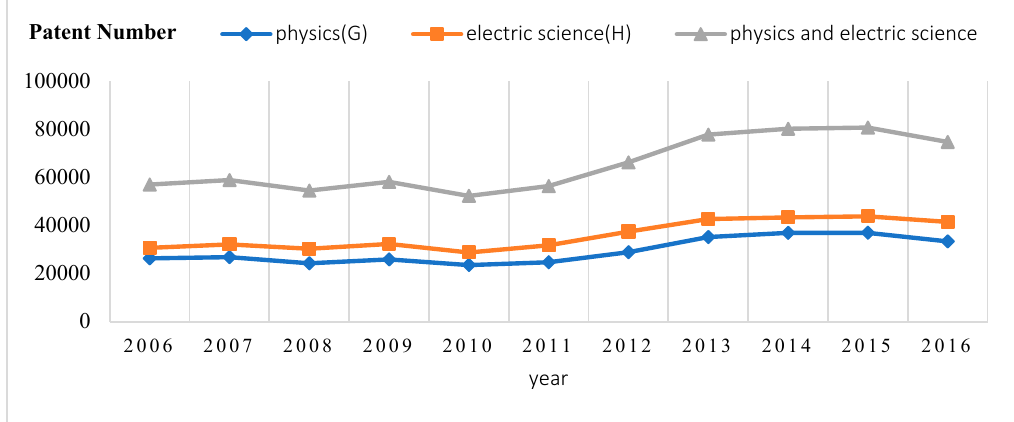
Figure 1. The total number or respective numbers of physics (G) and electrical science (H) patents according to international patent classification indices.